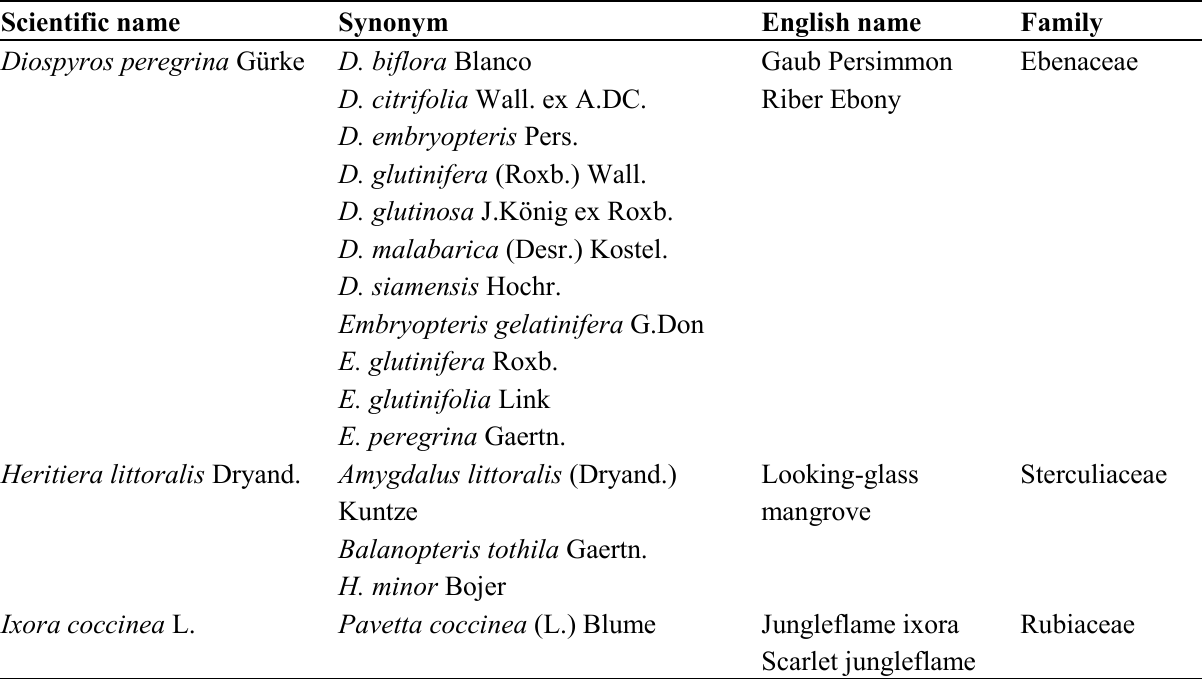
Table 1. Traditional antidiarrhoeal plants from Sundarbans mangrove